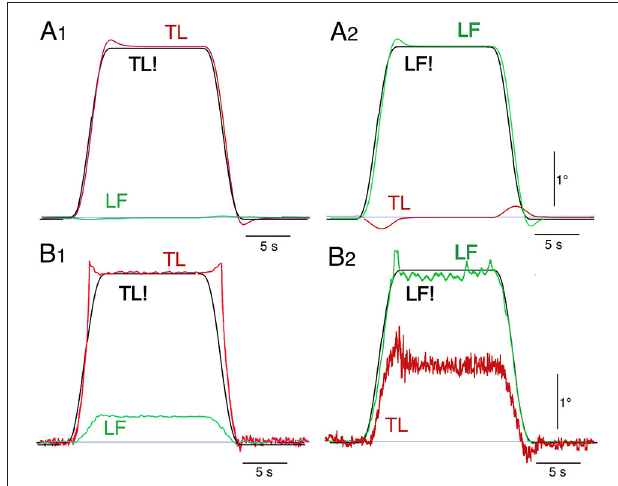
FIGURE 8 | Model simulation (A) and robot experiments (B) of internally generated (“voluntary”) rotations with ‘raised cosine velocity profile’ (amplitude, 4 ◦ ; dominant frequency, 0.2Hz) of TL (desired, TL!) in (A1,B1) and of LF (desired, LF!) in (A2,B2)